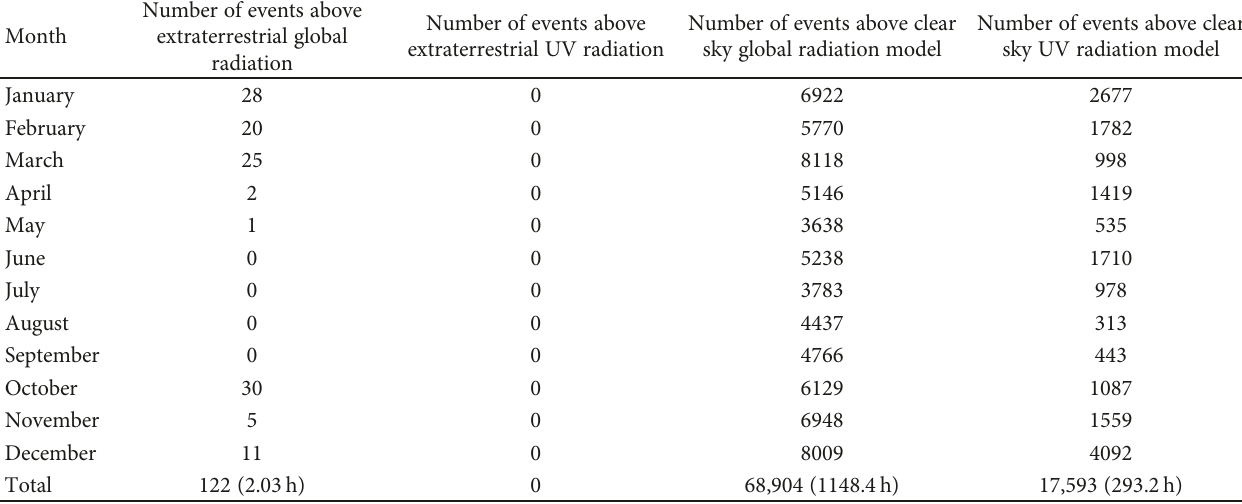
Table 3: Number of events above clear sky and extraterrestrial model for global solar and UV